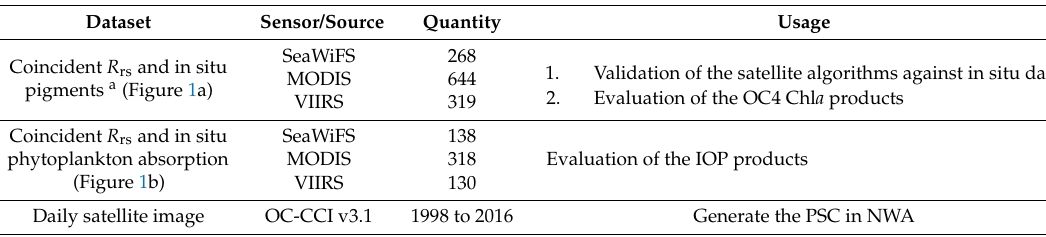
Table 1. List of datasets used in this